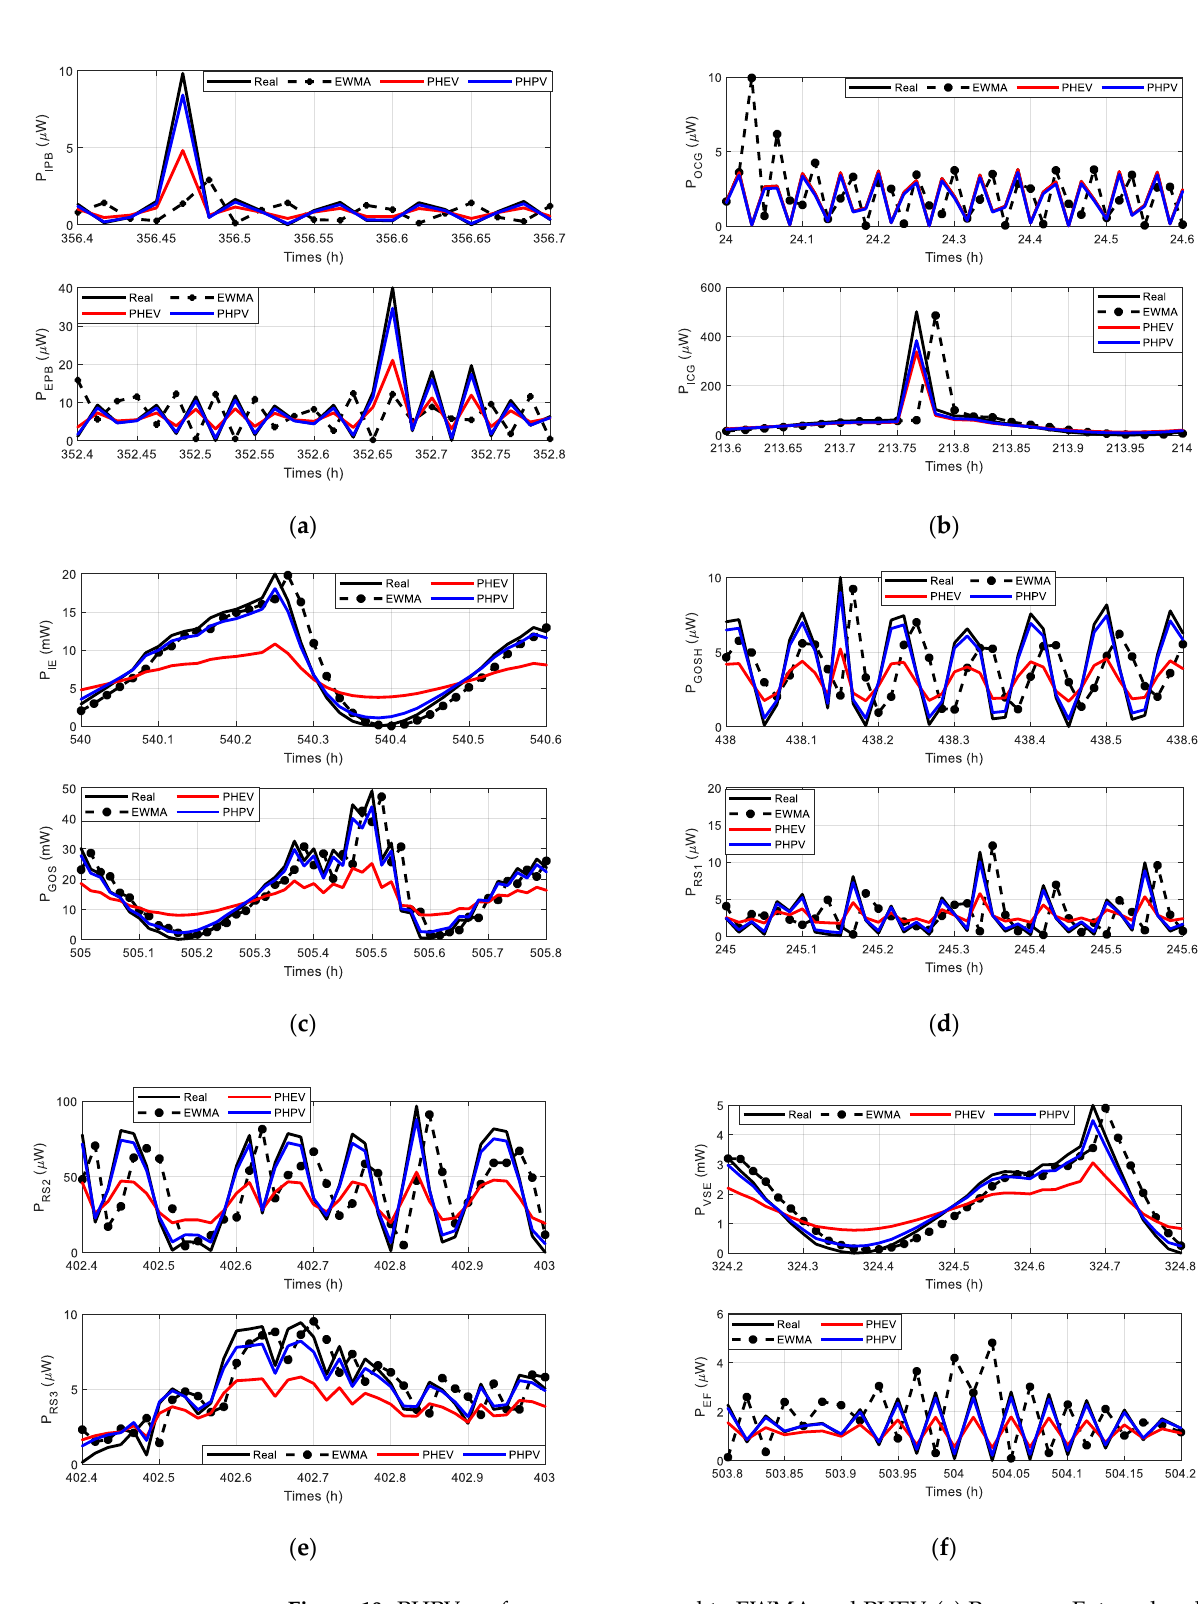
Figure 10. PHPV performance compared to EWMA and PHEV. ( a ) Power on External and Inside Crusher Pinion. ( b ) Power at the Outlet and Inlet of the Crusher Gearbox. ( c ) Power at Internal Engine and Gearbox at the Output Side. ( d ) Power on the Gearbox at the gearbox output Shaft and on the on the Radial Shaft 1. ( e ) Power on the Radial Shaft 2 and 3. ( f ) Power at the Ventilation Side of the Engine and Engine fan.